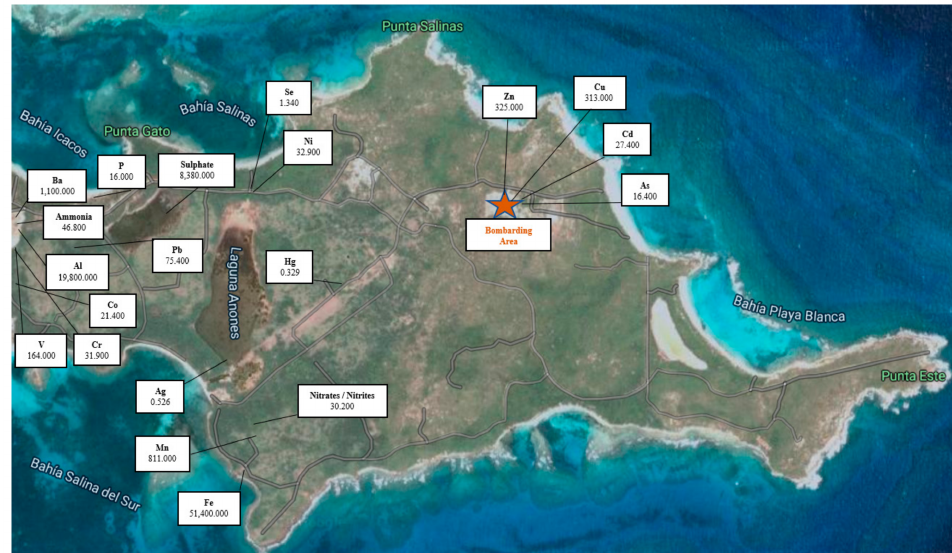
Figure 2. Toxic metal concentrations in soil within the impact bombing range on the east coast of Vieques Island. The concentrations of each metal are shown in the white rectangles (values are shown in parts per million). Source: Neftal í Garcia et al., 2000; samples taken by Scientific and Technical Services (SCT, Inc.); Digital image, USGS,